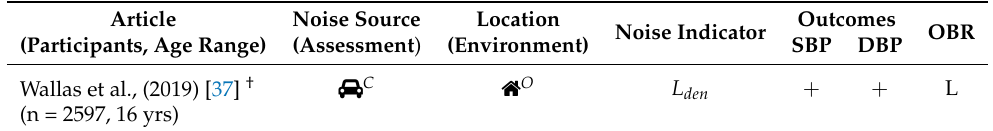
Table 5. Cardiovascular-based studies. SBP and DBP refer to systolic and diastolic blood pressure, respectively. ” + ” and ” − ” refer to statistical and non-statistical significant associations between outcome and noise indicators, and OBR to the overall bias rating, where L and H correspond to low and high OBR. Finally, dwellings and educational buildings are assigned by (cid:153) and (cid:19) ,